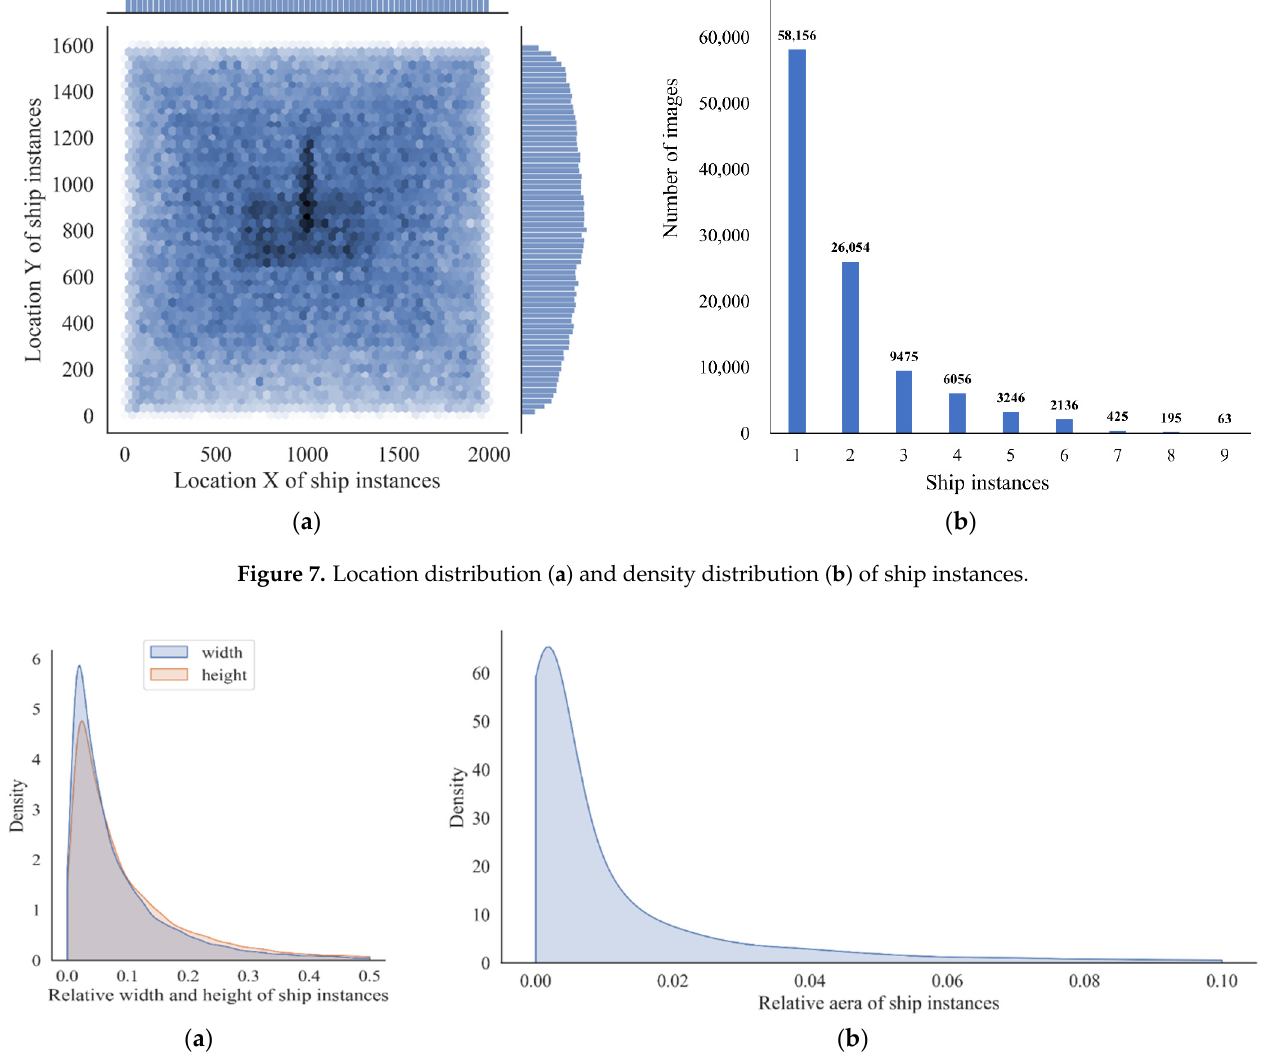
Figure 8. ( a ) Width, height, and ( b ) area distribution of the ship instance bounding box.